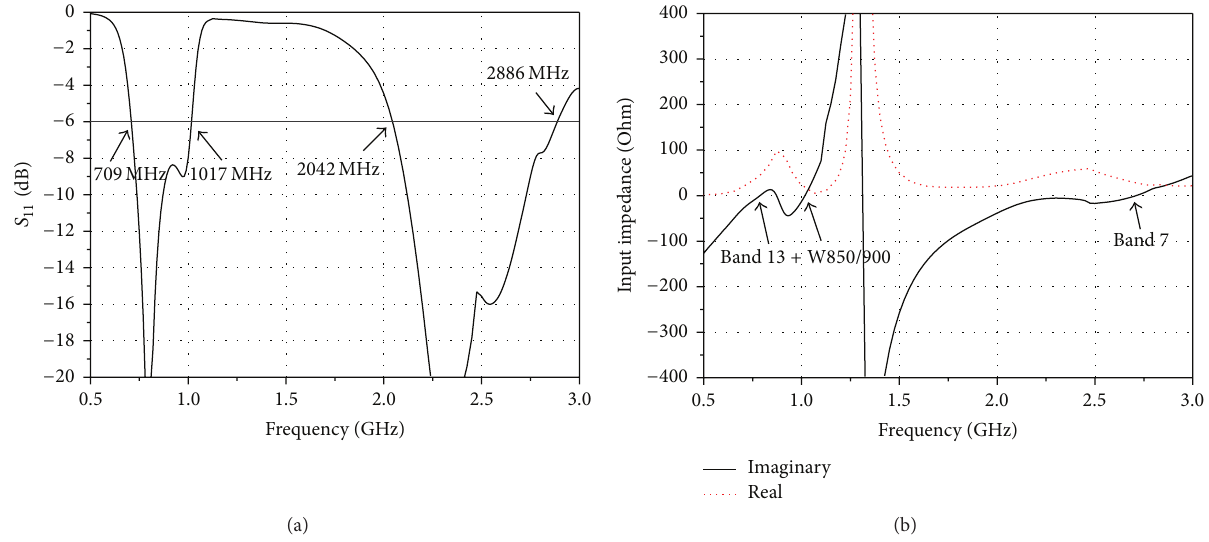
Figure 3: Performance of the unit element of the proposed MIMO antenna: (a) S parameter; (b) input impedance.